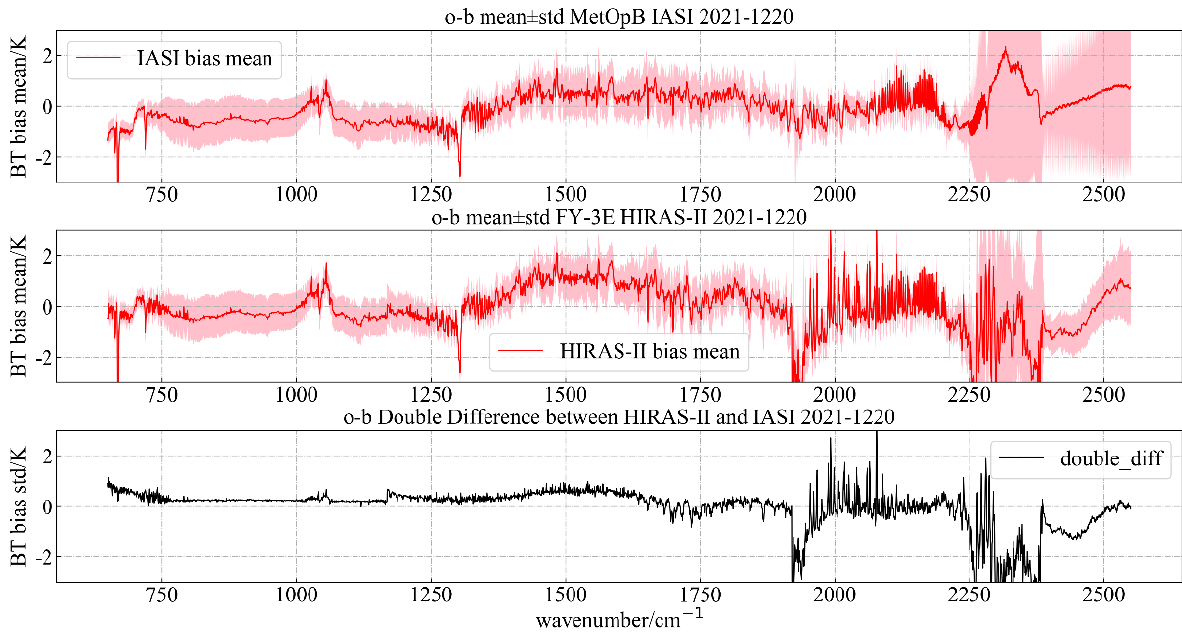
Figure 27. Comparison of HIRAS-II and IASI double difference.